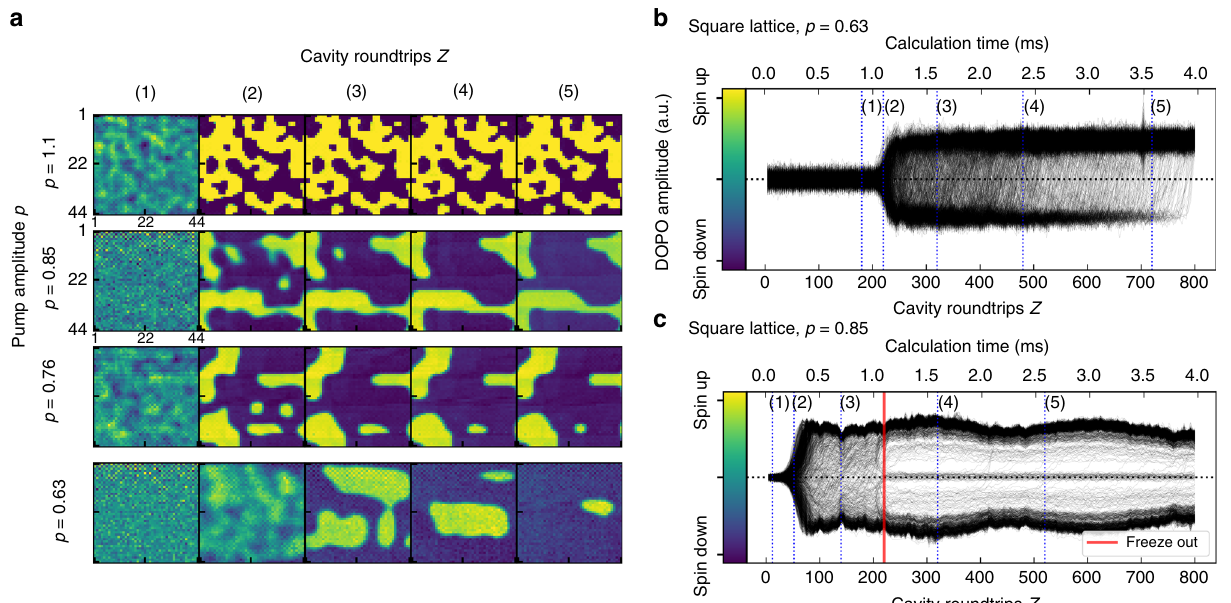
Fig. 2 Time evolution of the DOPOs during ground state search for the regular 2D lattice. a Snapshots of the time evolution of each DOPO ’ s in-phase quadrature amplitude c i at different pump amplitudes p = {1.1, 0.85, 0.76, 0.63} visualized in the regular lattice structure. Blue indicated the spin-down and yellow the spin-up con fi guration (colorbar in ( b )). The DOPO amplitude grows from a squeezed vacuum state (1) to the saturation amplitude (2). As the amplitude grows, domains with distinct domain walls are formed. As the calculation continues, the domain walls start to move and domains start to shrink until eventually all domains have evaporated and the machine has reached the ground state. b , c Exemplary time evolution for the in-phase quadrature amplitude of each DOPO at p = 0.63 ( b ) and p = 0.85 ( c ). In ( b ), the ground state is eventually reached after around 800 cavity roundtrips. The red line in ( c ) indicates the point where evolution to the ground state prematurely stops and the domains remain frozen in their fi nal con fi guration (i.e.,